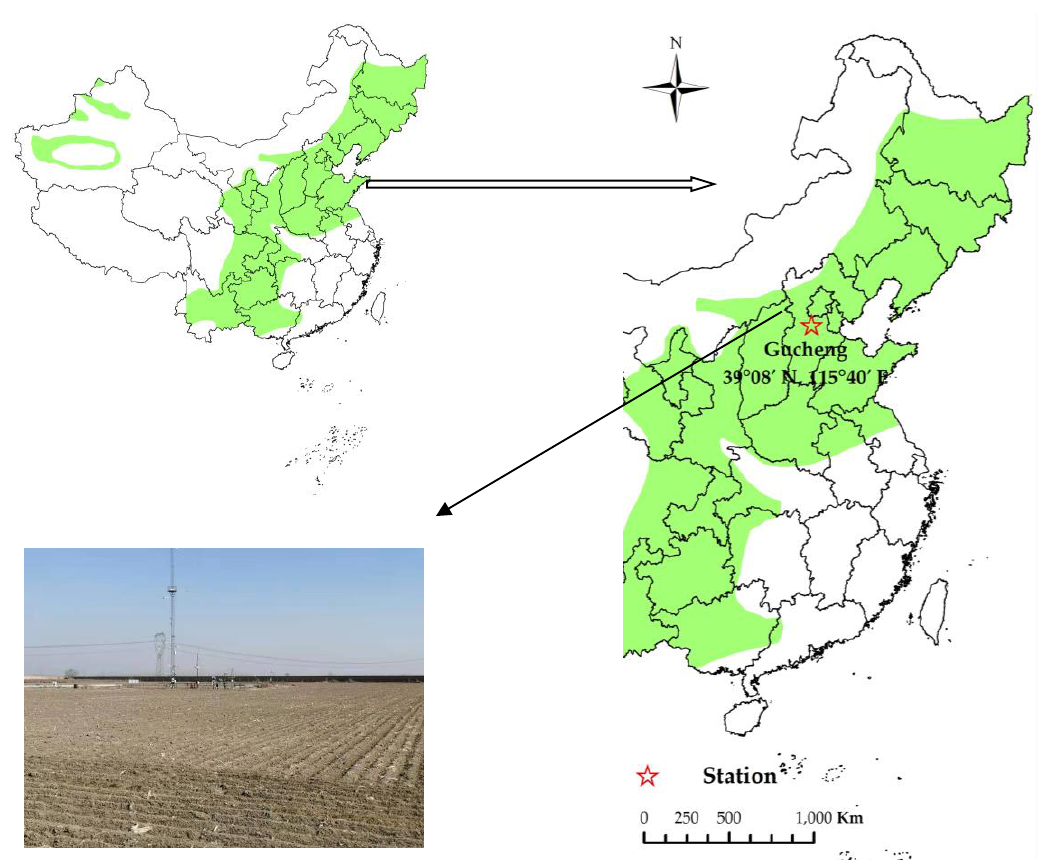
Figure 1. Distribution of geographical location in Gucheng Station (the green shows the maize planting area in China), the red star represent the location of experimental